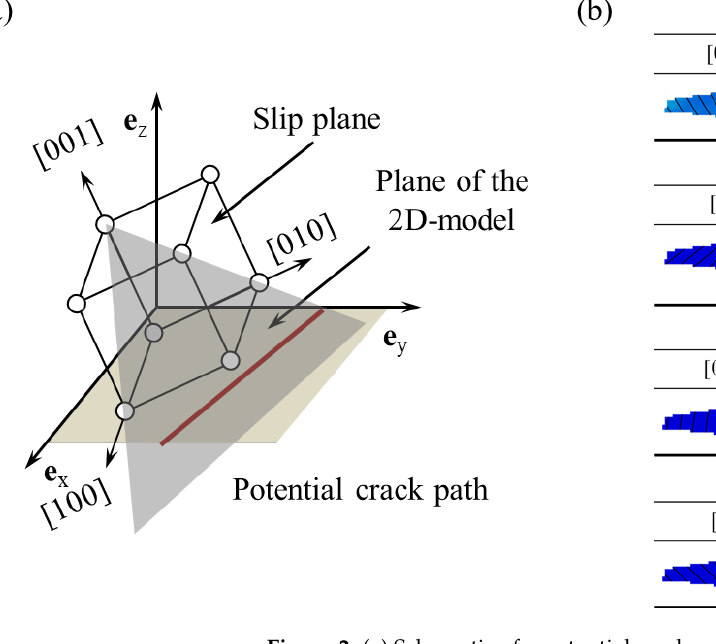
Figure 2. ( a ) Schematic of a potential crack path defined as the intersection of the slip plane and the 2D finite element model. ( b ) An example of the potential crack paths for a single crystalline grain. The path with the highest fatigue indicator parameter (FIP) is highlighted with a bold line.